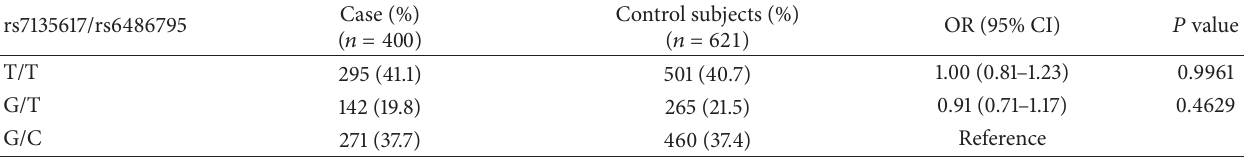
Table 4: Haplotype frequencies of the ORAI1 gene in rheumatoid arthritis patients and normal